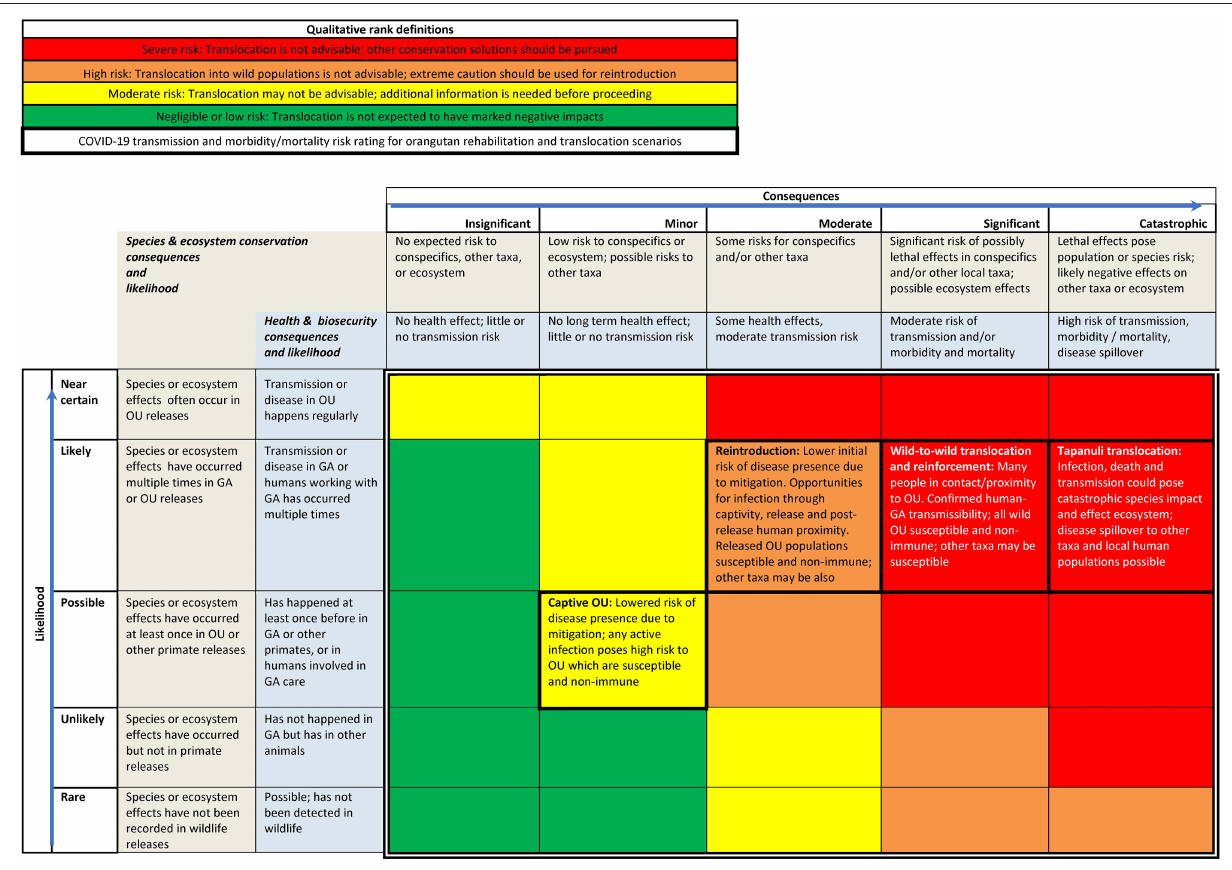
identification but almost never monitored post release